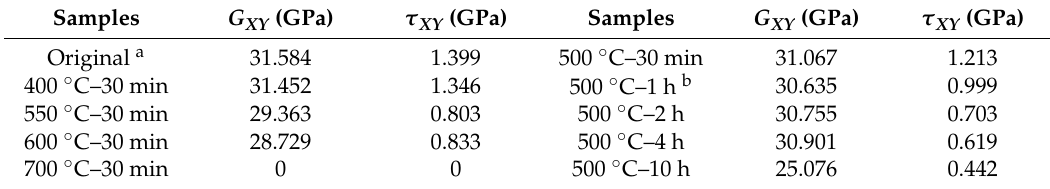
Table 2. Shear properties between graphite layers calculated by Equations (3) and (6).